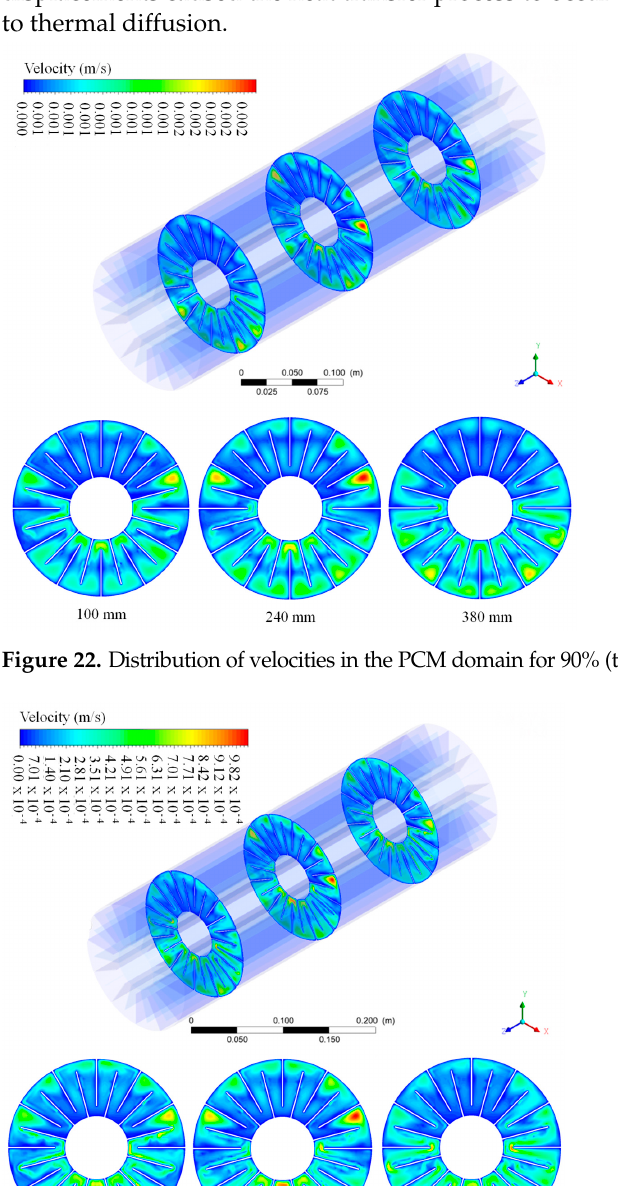
Figure 24. Distribution of velocities in the PCM domain for 50% (t = 6522 s) of its volume in a liquid state.